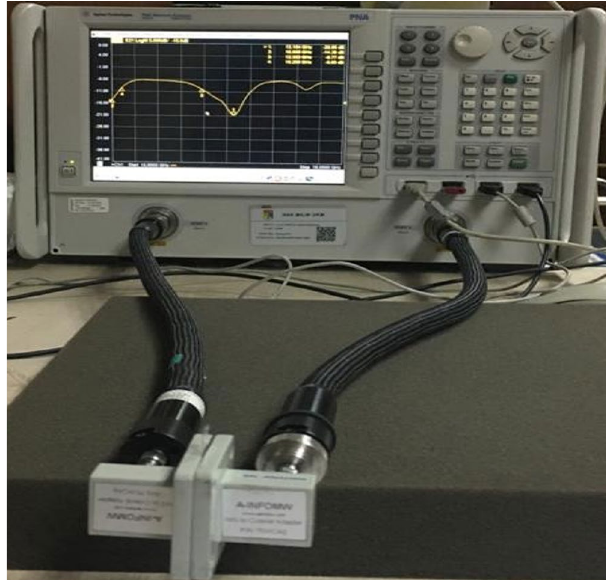
Figure 24. Experimental setup to measure S 21 for the unit cell.